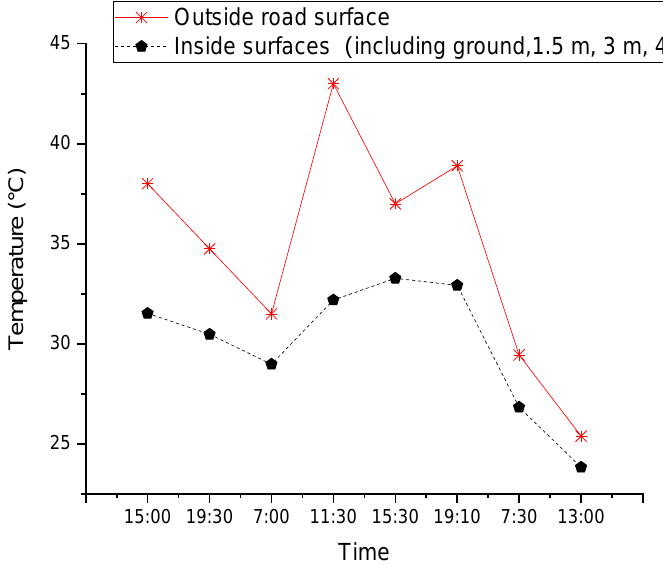
Figure 11. Average surface temperatures inside and outside.